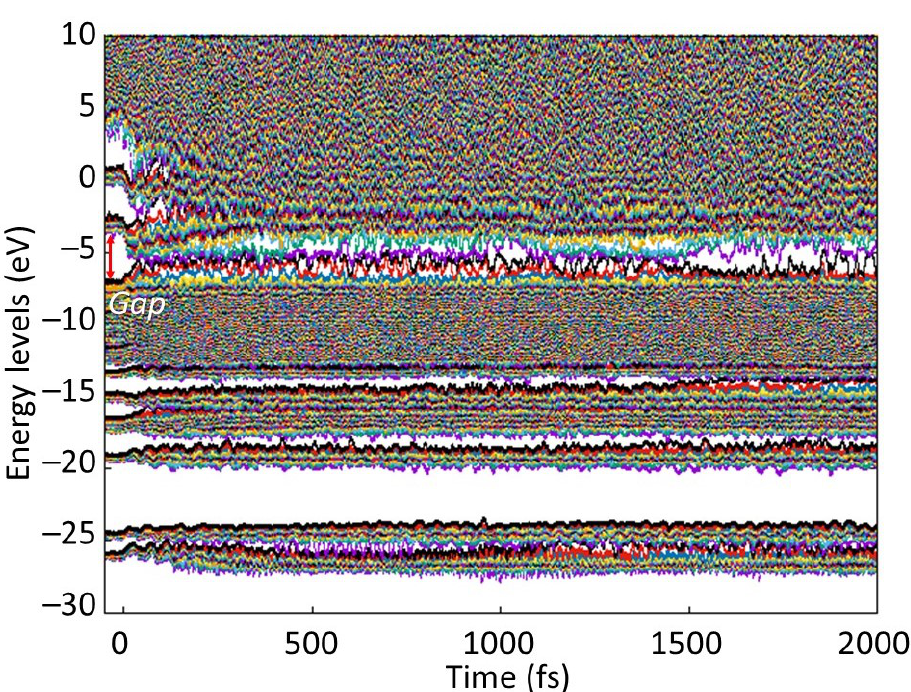
Figure 8. Electronic energy levels (eigenstates) in PMMA irradiated with 0.5 eV/atom deposited dose. HOMO-LUMO gap is marked with a red arrow.